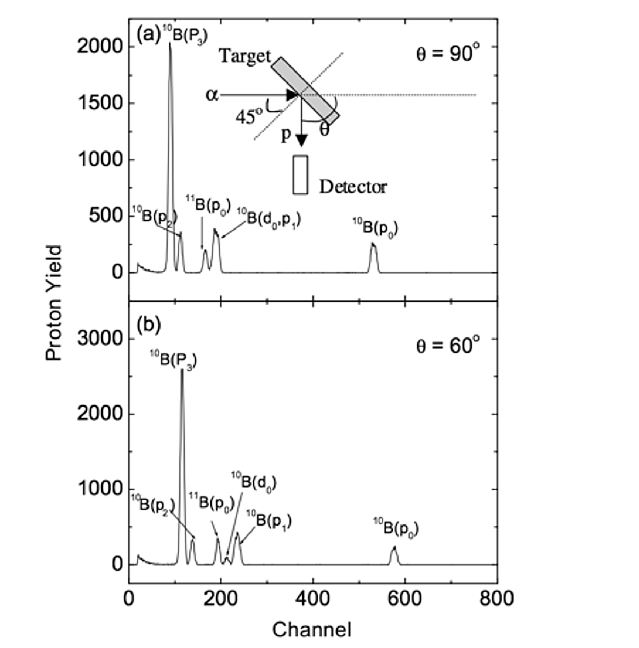
Figure 4: Energy spectrum of proton from the 10B(a, p) 13 C reaction using a natural abun- dance boron thin film ( 10 B 19.61% and 11 B 80.39%) [4].